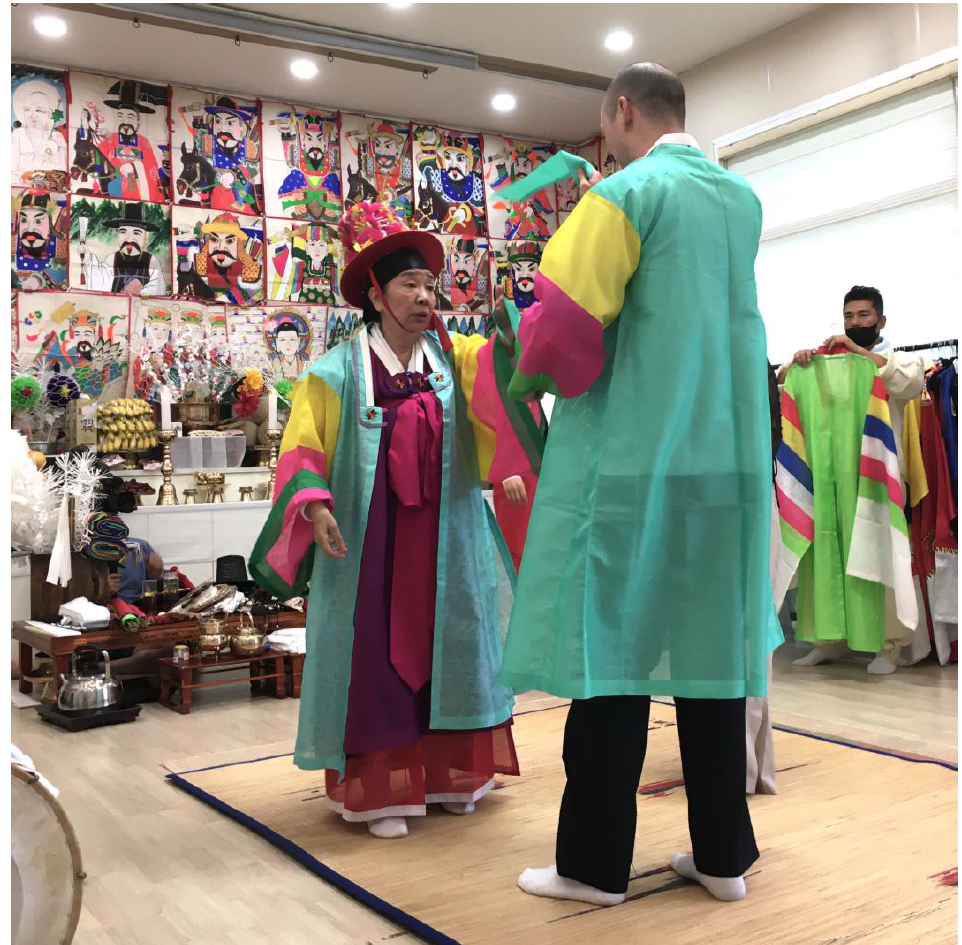
Figure 3. Mudang Yi Hae-gyŏng instructing an American visitor how to arrange his costume for a mugam dance during ritual. July 2022, the photograph was taken by the author with consent from the people depicted.